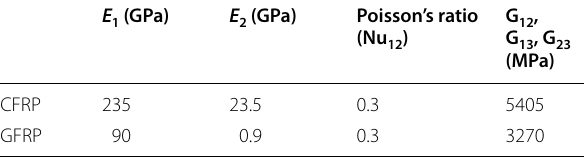
Table 12 Elastic performance of FRP sheets.